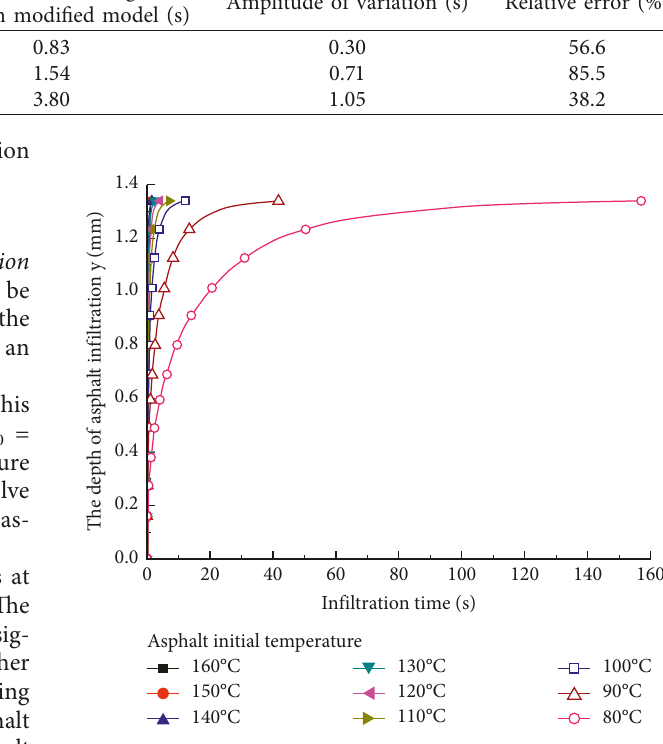
Figure 5: Infiltration curves of asphalt at different initial